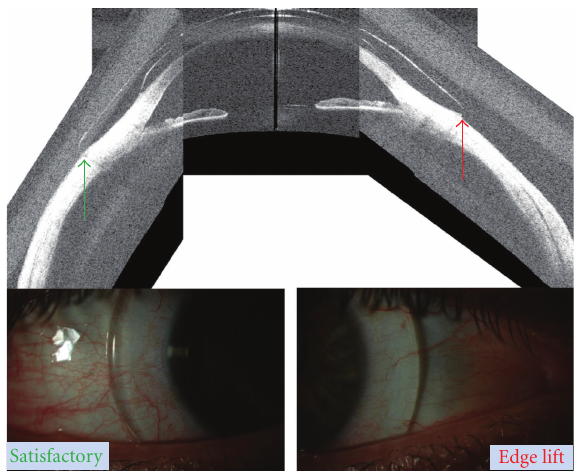
Figure 9: Horizontal montage (TD-OCT) and slit lamp photographs of Eye #6. Green arrow indicates satisfactory fit temporally with correlating slit lamp image below; red arrow points to edge lift which is marked by shadow just peripheral to the nasal edge of the haptic in the slit lamp image